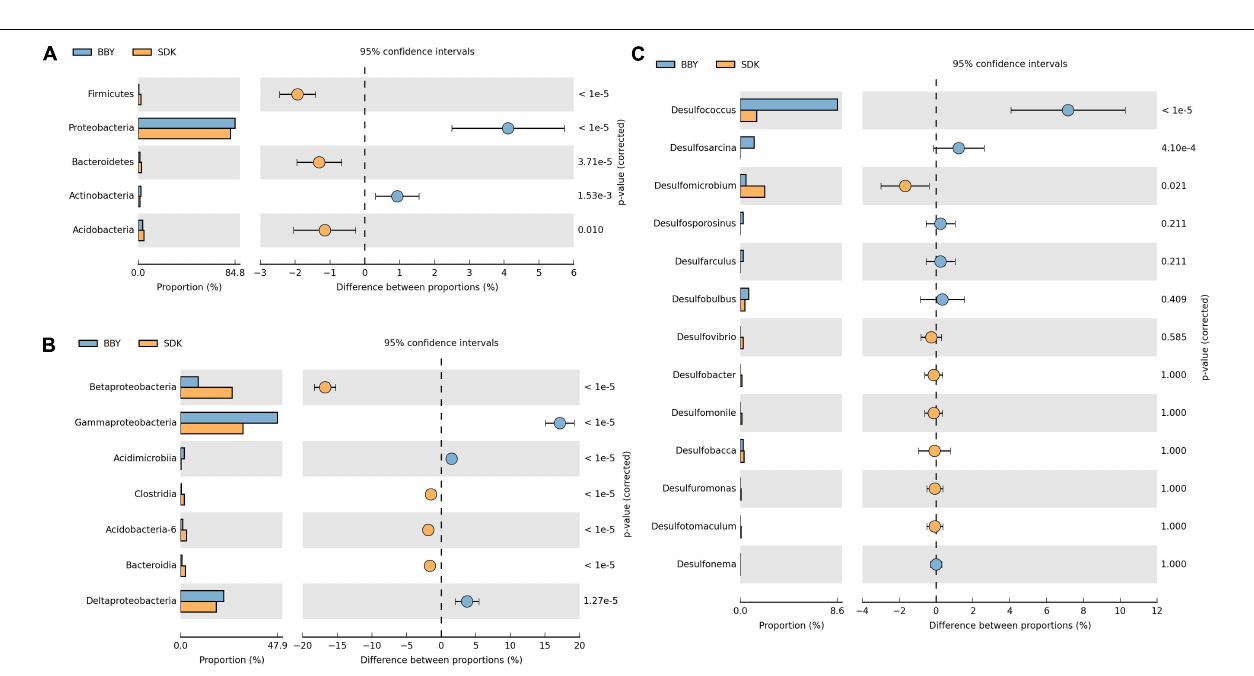
FIGURE 4 | Potential ecological risk indices ( RI ) of heavy metals in intertidal sediments from various sites at the Yangtze River estuary sampled during October 2015 and April 2016. WSK, SDK, and LHK were estuarine mudflats, BBY and DWS were salt marshes. The potential ecological risk levels represented by the RI values are indicated by dotted lines.